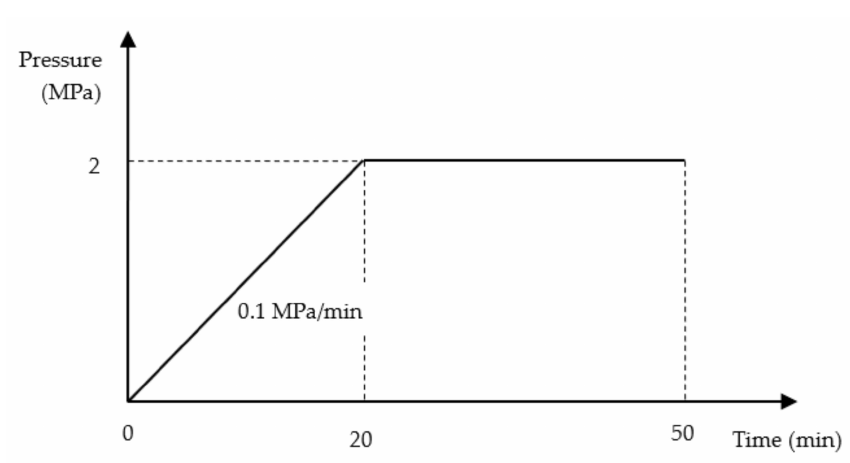
Figure 5. Curve of gas pressure on superplastic